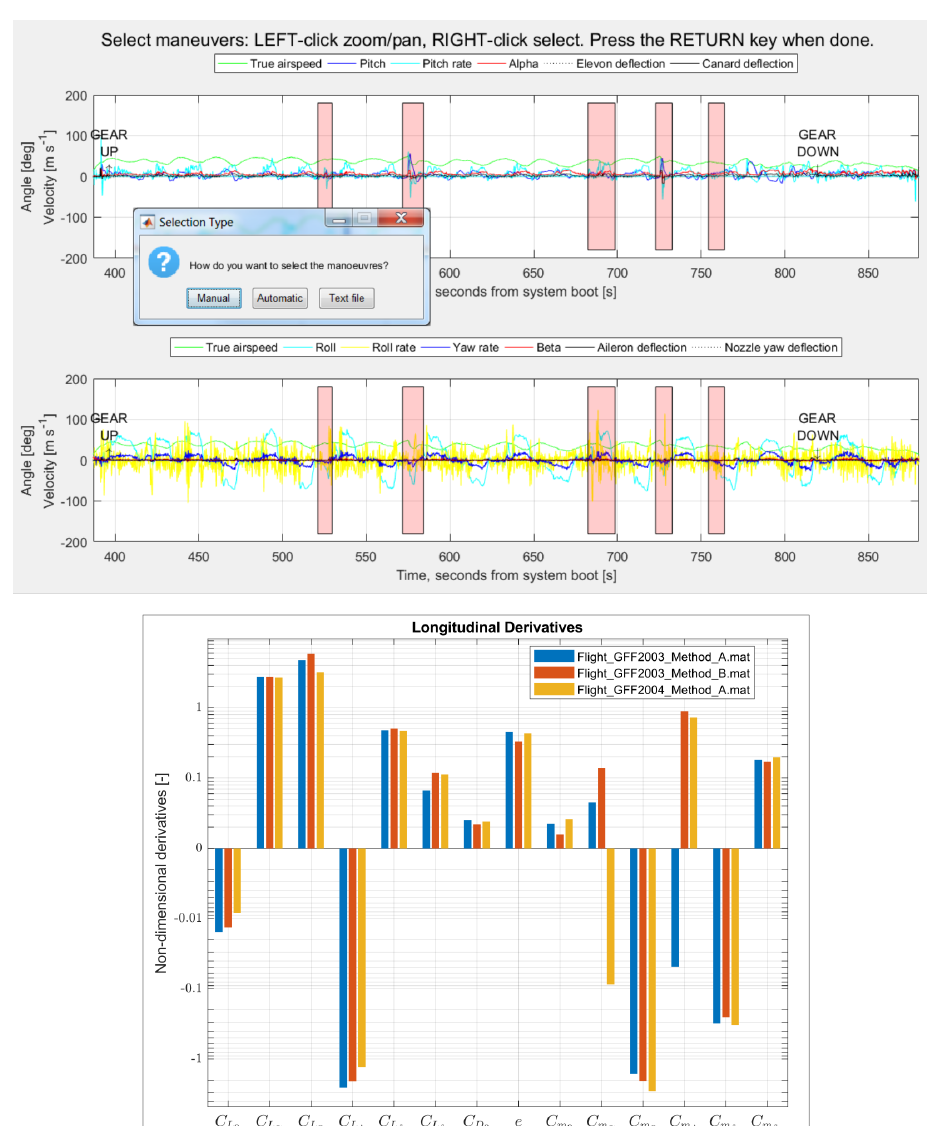
Figure 14. Manual selection of a set of test manoeuvres ( top ) and graphical comparison of parameter estimation results for different sets and methods ( bottom